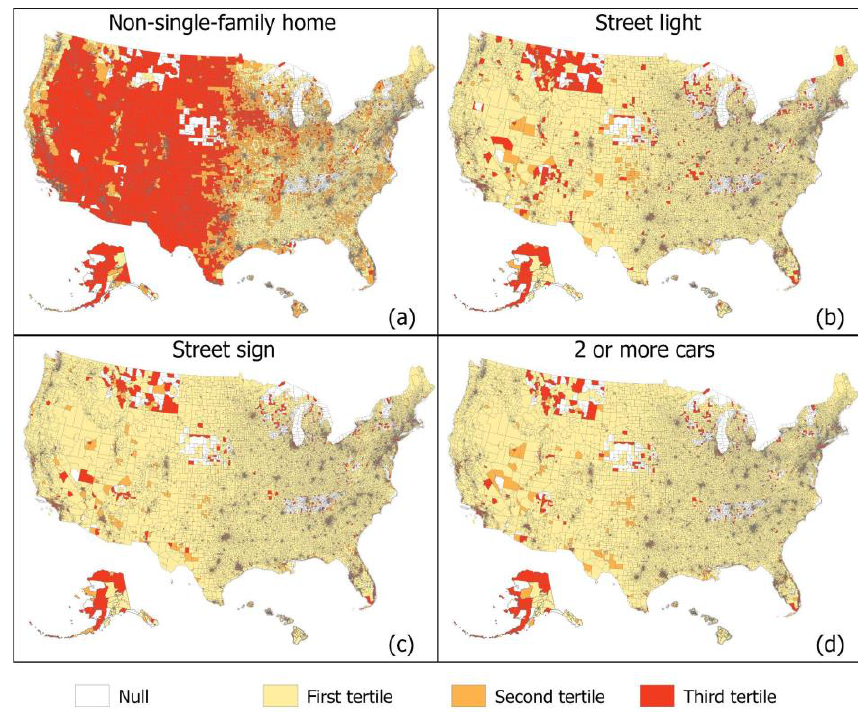
Figure 4. Census tract level distribution of GSV-derived neighborhood characteristics. ( a ) non- single family home, ( b ) street light, ( c ) street sign, ( d ) two or more cars. Darker colors signal higher prevalence of a neighborhood